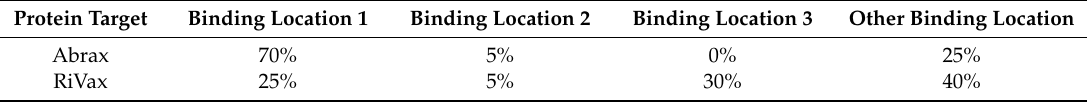
Table 2. Percent of Top Ten Decoys from XPairIt Analysis at Each Binding Location on Abrax or RiVax (Shown in Figure 4) for the Tier 1 Binding Consensus,